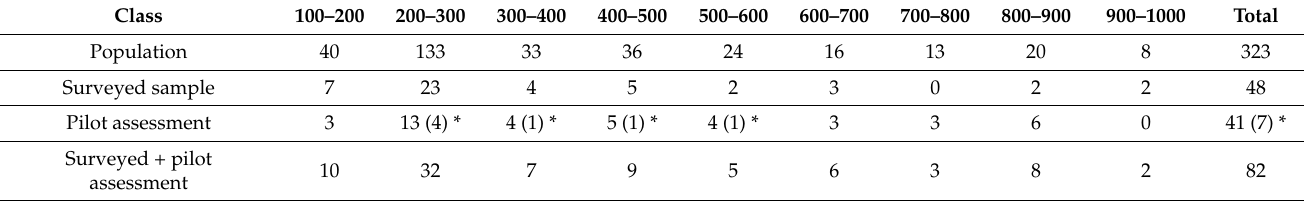
Table 11. Number of surveyed and pilot assessment hospital samples by licensed bed